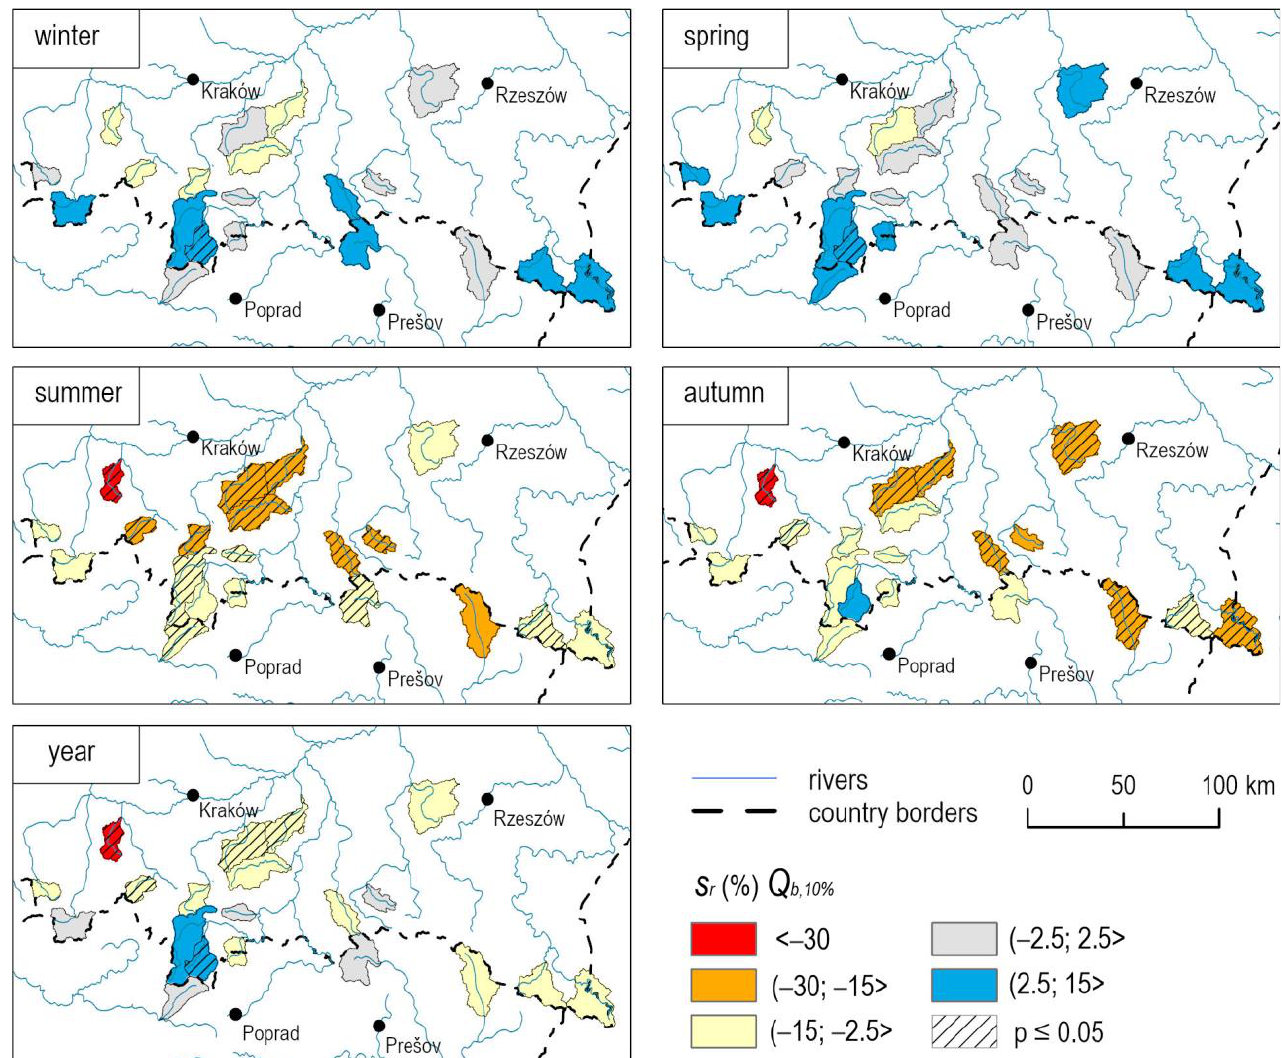
Figure 6. Relative changes in low baseflow values ( Q b, 10% ) in the years 1970 – 2019. Changes in the high baseflow ( Q b,90% ) were mostly insignificant in the analyzed catchments (Figure 7). The decline in the high baseflow was strong in the summer in three catchments located in the middle mountains (nos. 12, 13, 15)—the relative change was about − 8%. In the studied foothill area, significant trends were noted for the winter high baseflow in the Wieprz ó wka catchment, no. 19 ( − 0.05 mm/10 years, s r = − 8%), and for the annual high baseflow in the Uszwica catchment, no. 18 ( − 0.03 mm/10 years, s r = −